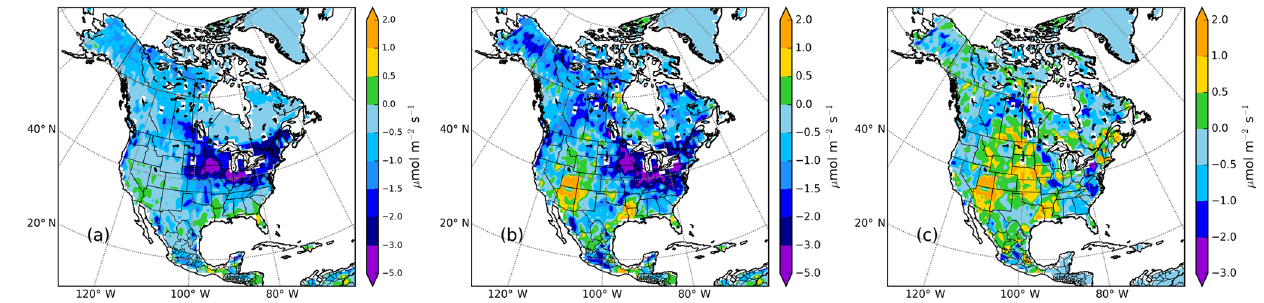
Figure 5. Mean prior (a) and optimized (b) net biosphere fluxes, and the mean adjustment (optimized minus prior) (c) for summertime (June–July–August). Note that the color scale used in (c) is different from the one used in (a) and (b)